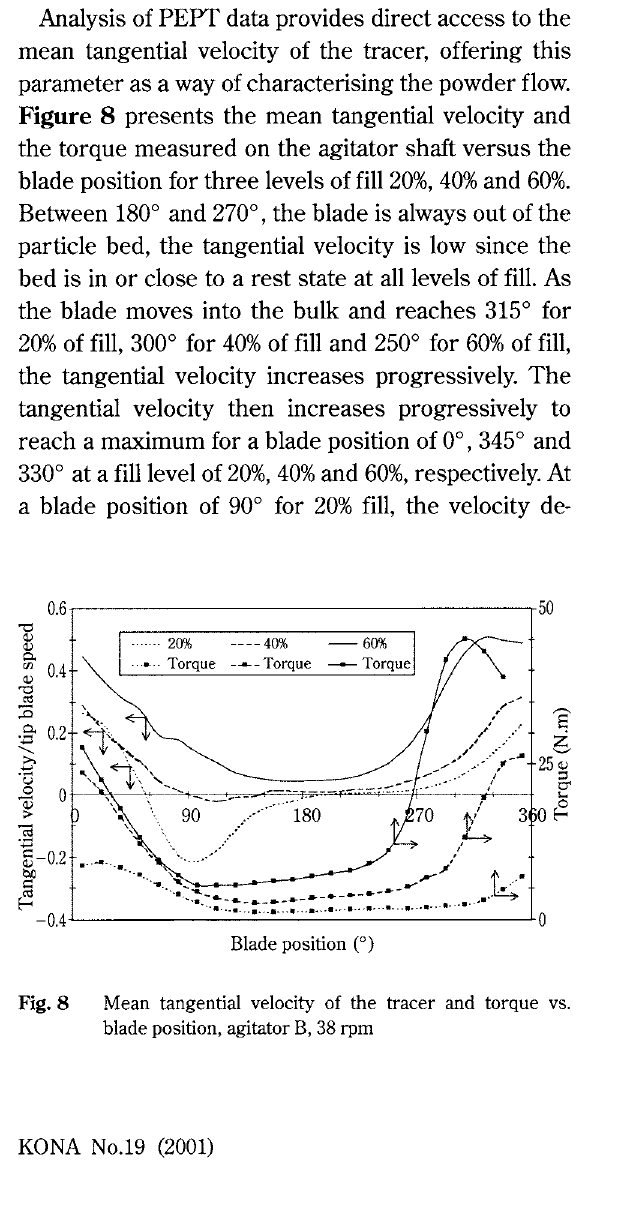
Mean tangential velocity of the tracer and torque vs. blade position, agitator B, 38